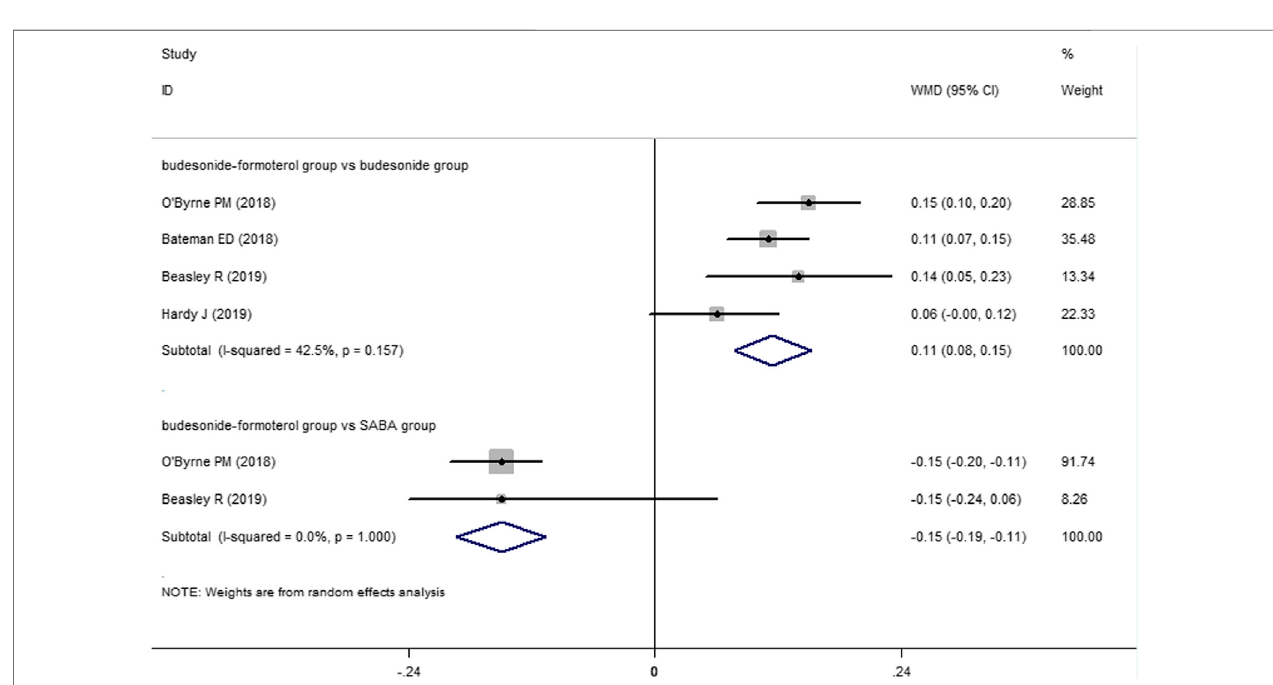
FIGURE 5 | Comparison of the difference of change in the ACQ-5 in the three treatment groups.